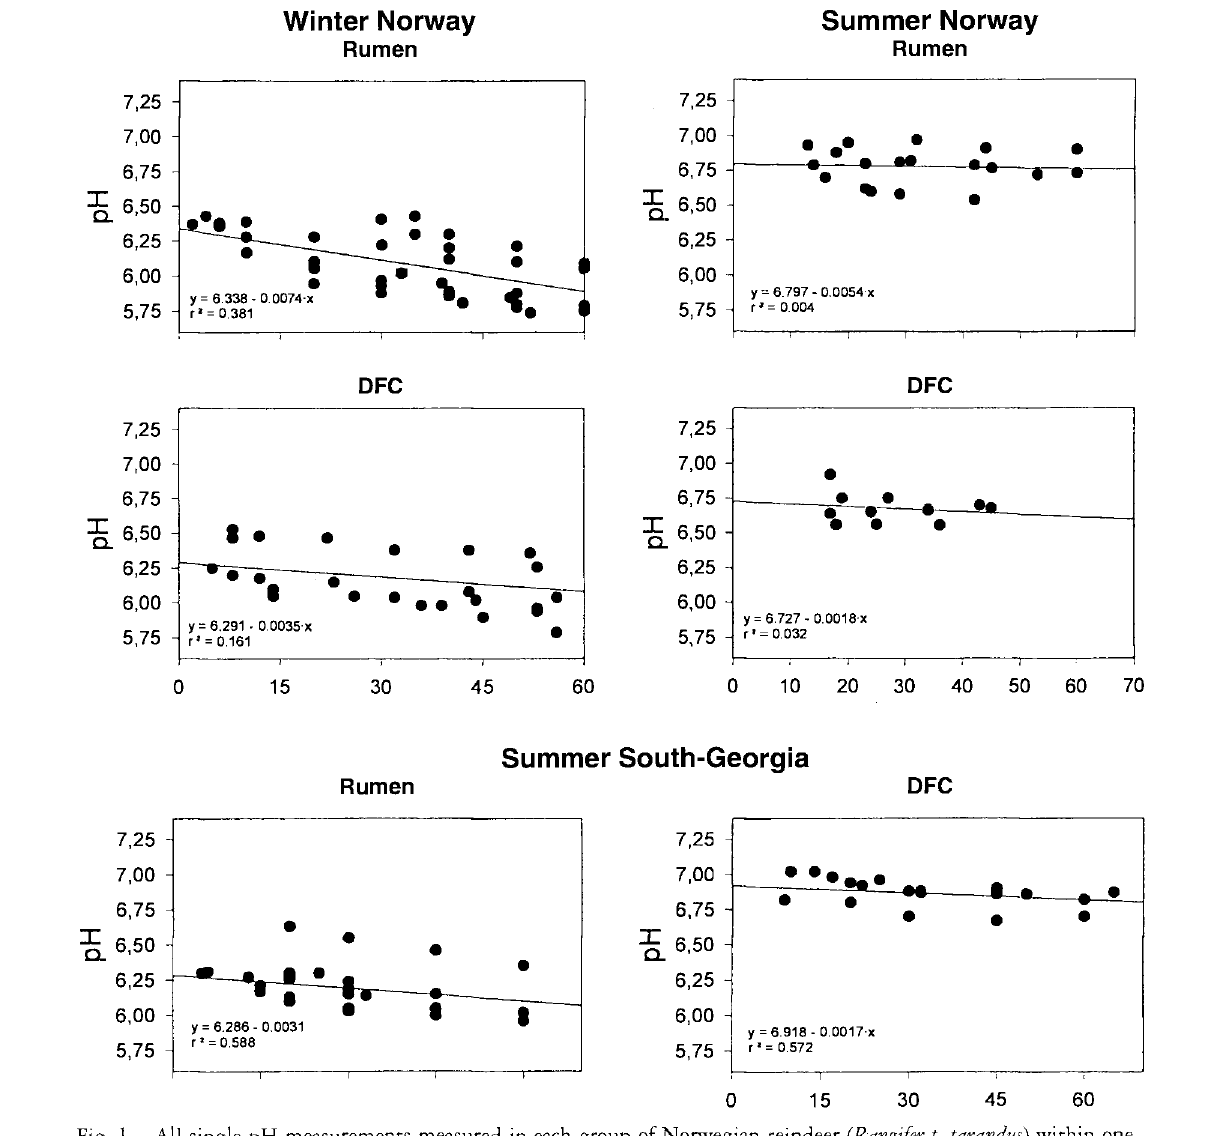
Fig. 1. All single pH measurements measured in each group of Norwegian reindeer (Rangifer t. tarandus) within one hour of death in the rumen fluid and distal fermentation chamber (DFC) content respectively on South Georgia in summer (n = 6) in = 3), northern Norway in late summer (n = 4) (n = 3) and northern Norway in winter (n = 9) (n =